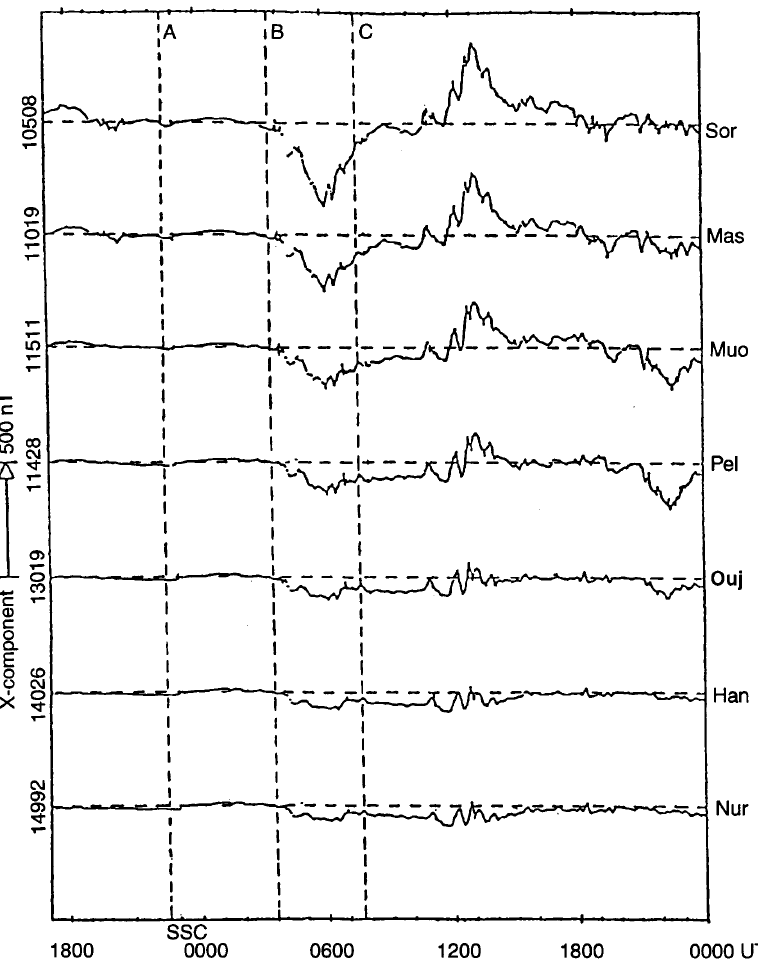
Fig. 4. X -component plot of magnetic field on 27 May 1993 observed on the Scandinavian mag-